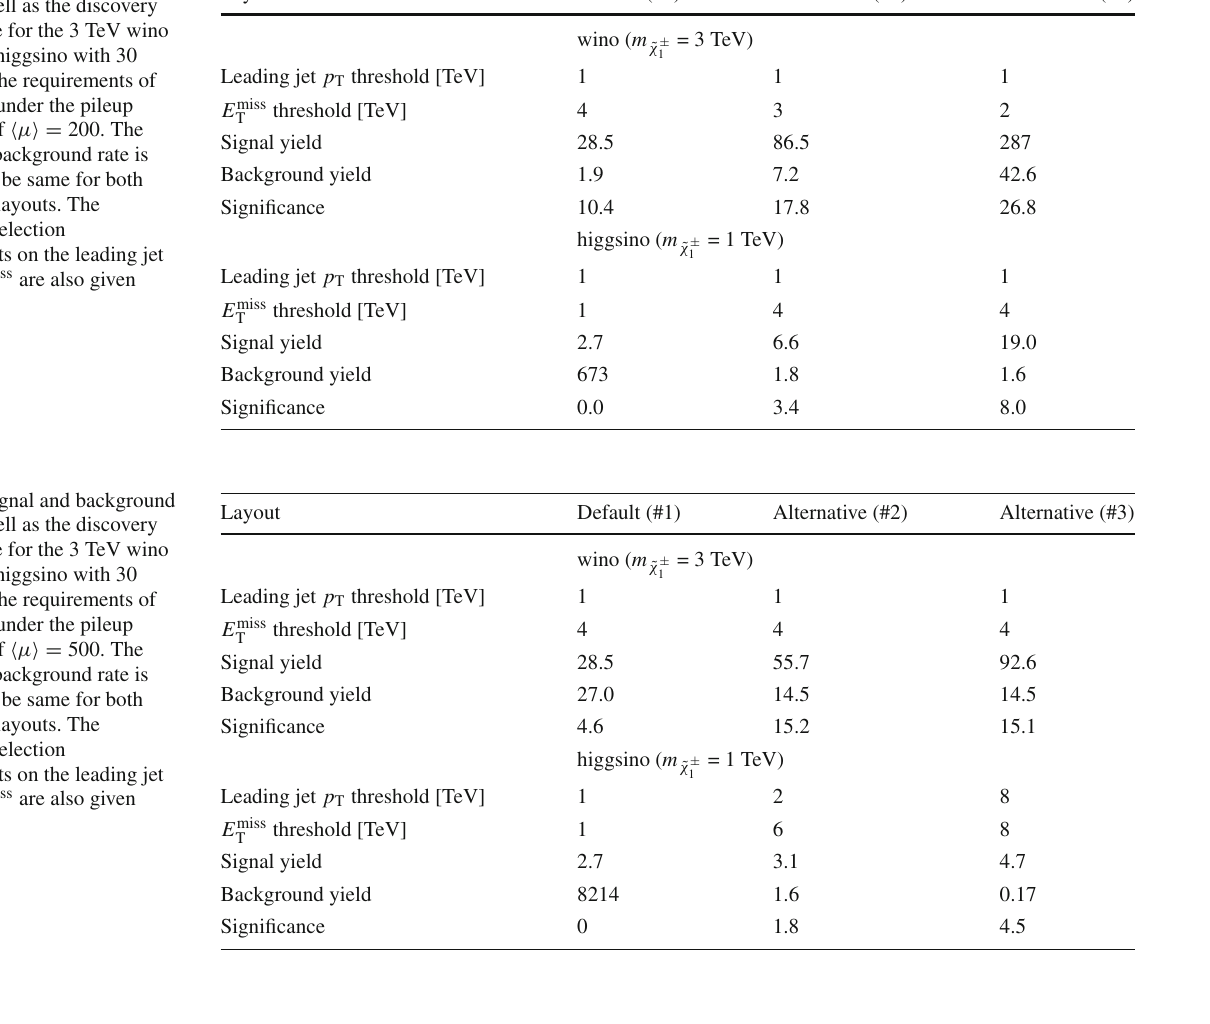
yields as well as the discovery significance for the 3 TeV wino and 1 TeV higgsino with 30 ab − 1 with the requirements of = 5 under the pileup N hit layer condition of (cid:8) μ (cid:9) = 200. The